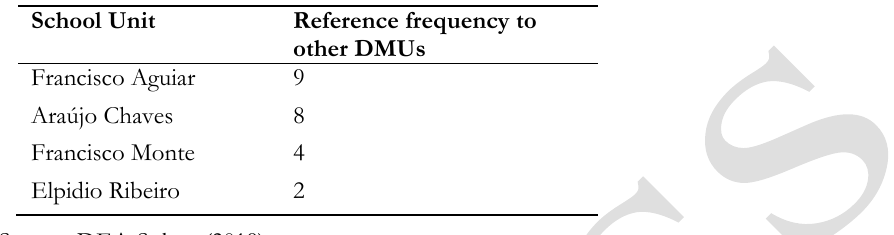
Table 3 – Reference frequency of the main DMUs.